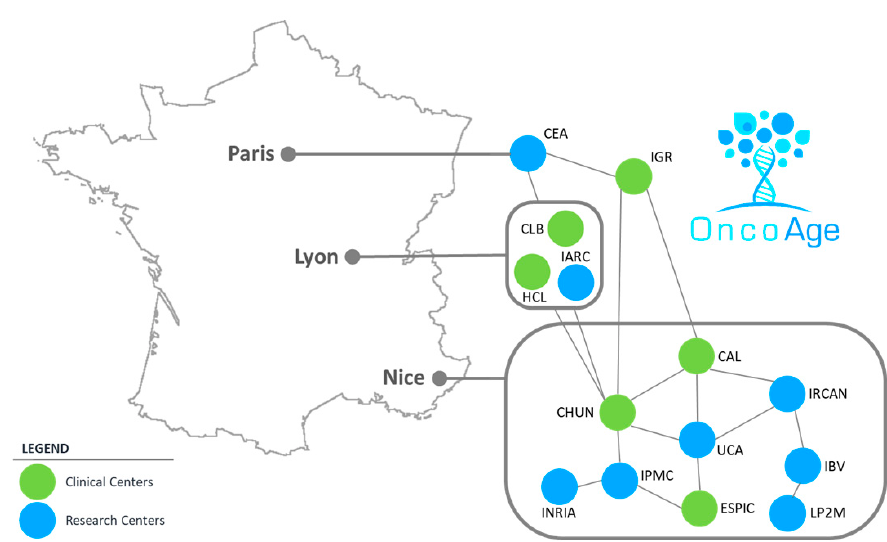
Figure 3. The OncoAge consortium members. CEA: Centre d’Energie Atomique; IGR: Gustave